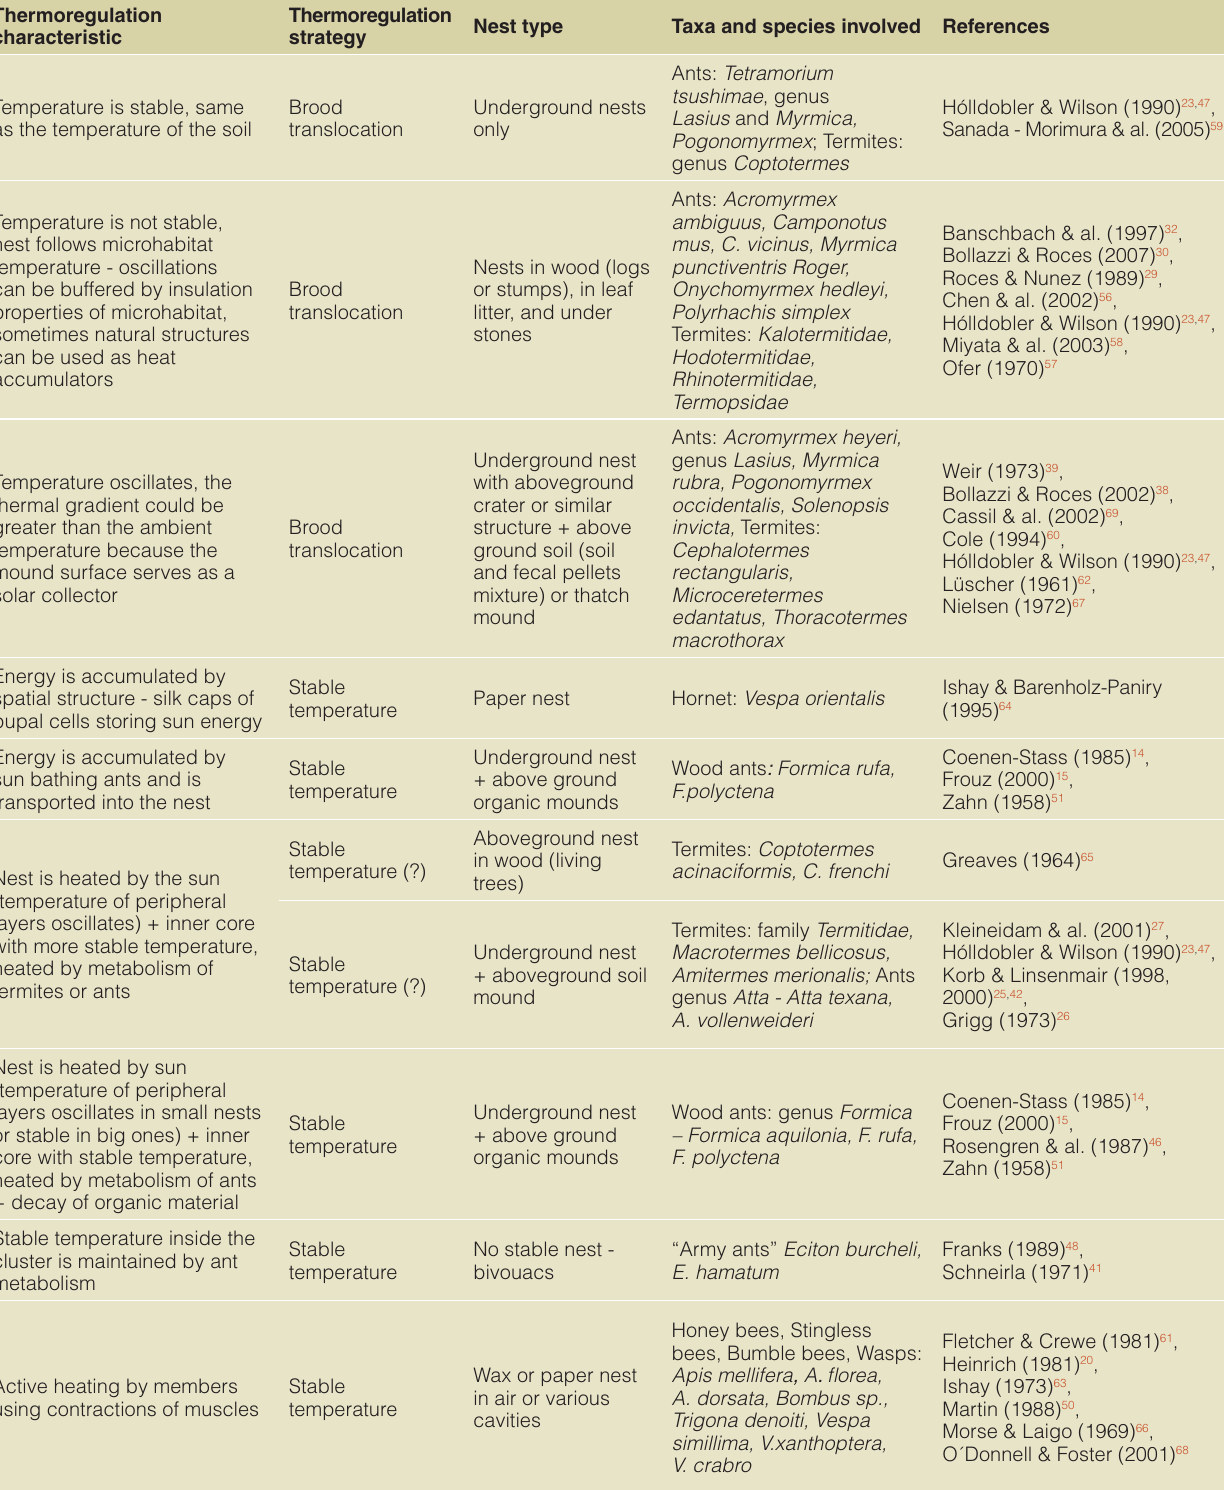
Table 1. Examples of thermoregulation and nesting strategies in social